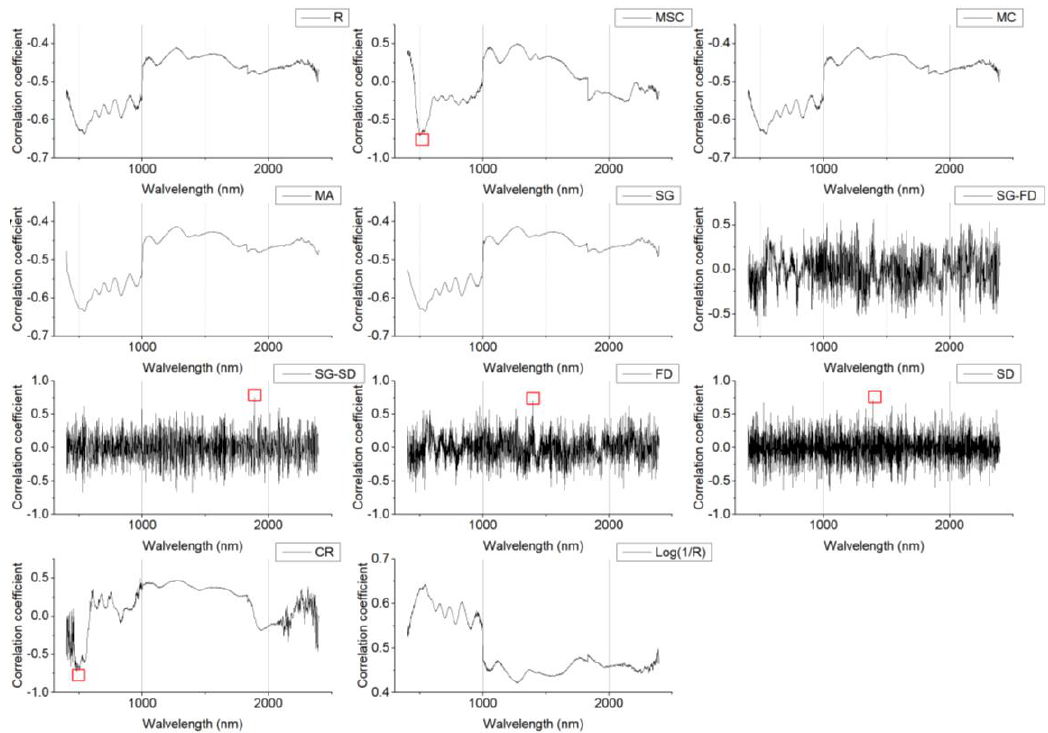
Figure 5. Changes in the soil organic matter (SOM) content and correlation coefficients represented using different spectral indices (Northwest China).